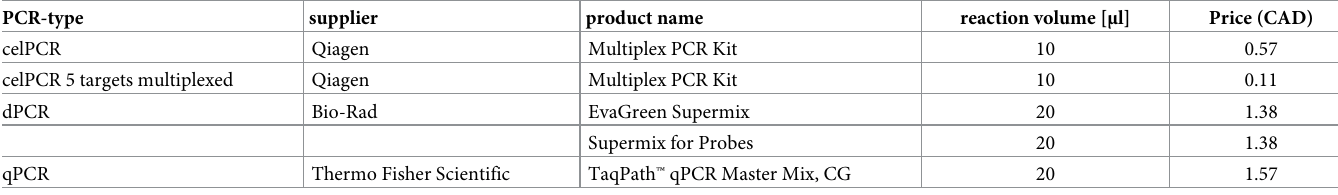
Table 1. Comparison of PCR reagent